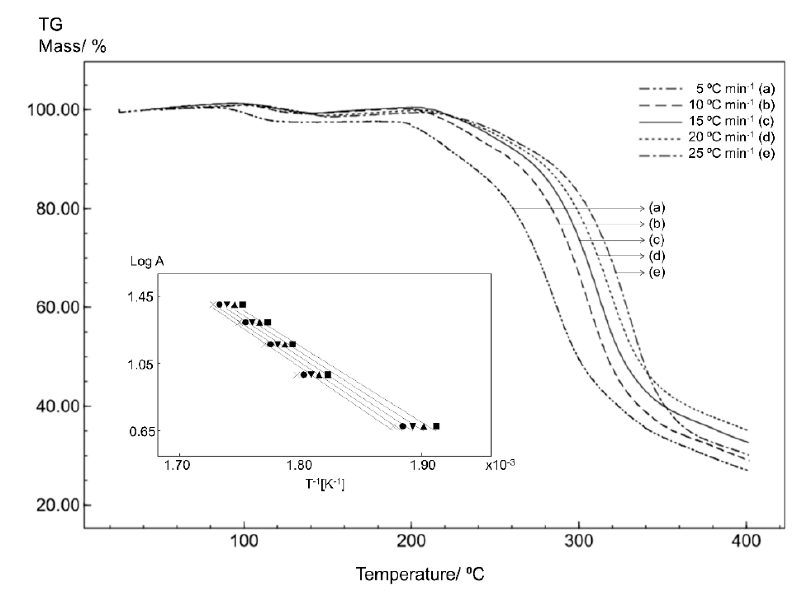
Figure 8. The TG curves for STG obtained for different heating rates with a synthetic air atmosphere (50 mL min − 1 ). The inset shows the linear tendency of the correlation curves applying the Ozawa method.